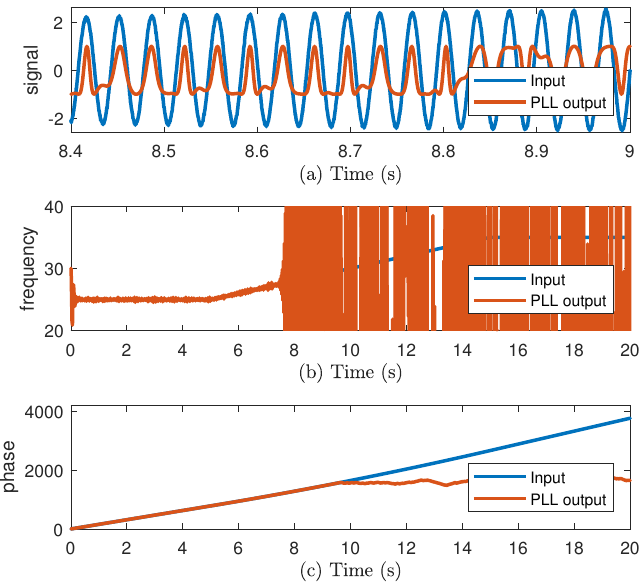
Figure 2. ( a ) Input and Phase-Locked Loop (PLL) sinusoidal output v f , ( b ) frequency, and ( c )